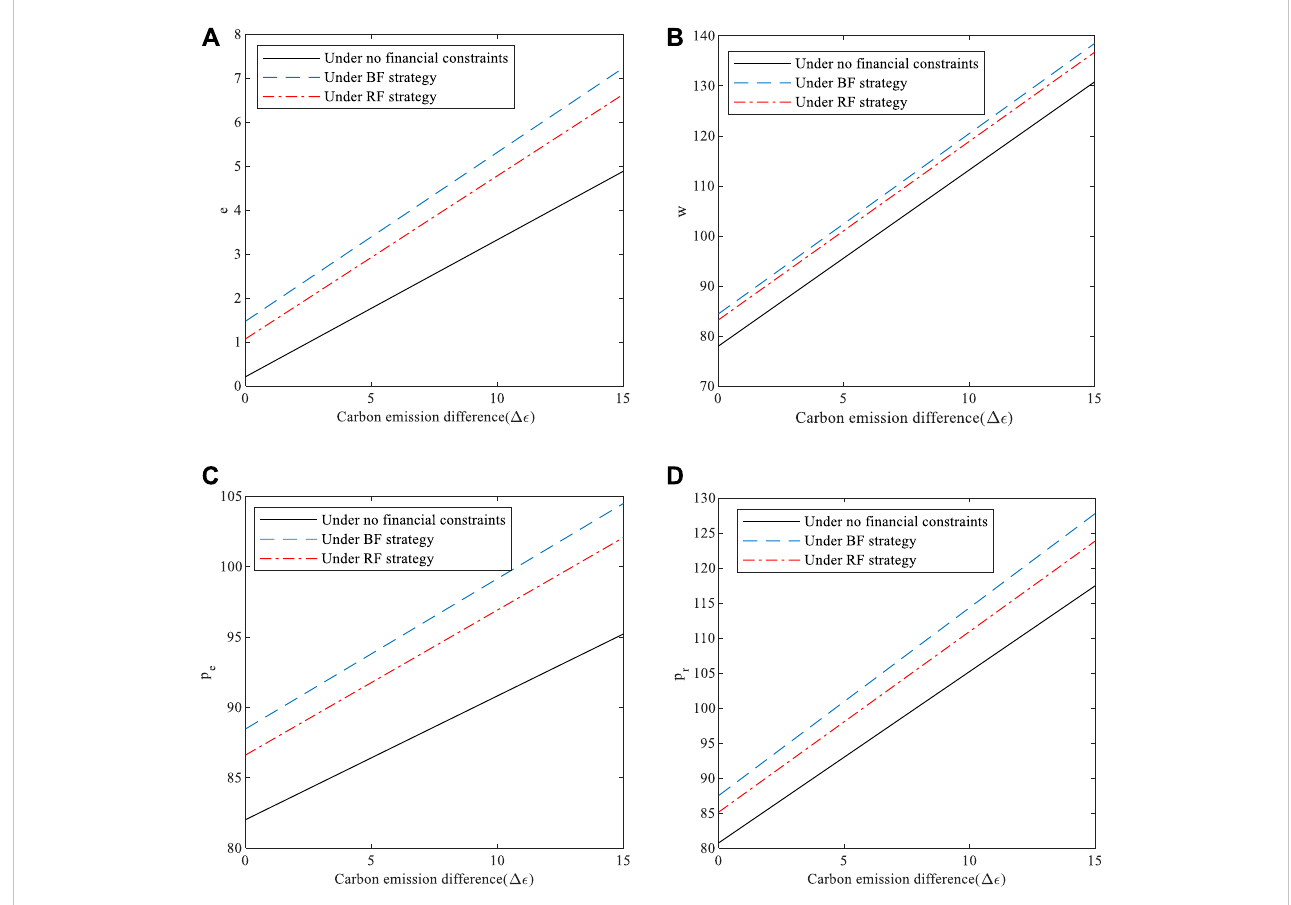
FIGURE 8 (A) Impact of carbon emission differences on fresh-keeping efforts (B) Impact of carbon emission difference on wholesale prices by the distribution channel (C) Impactofcarbonemissiondifferenceonthedirectsaleschannelsalesprice (D) Impactofcarbonemissiondifferencesonthedistributionchannel sales